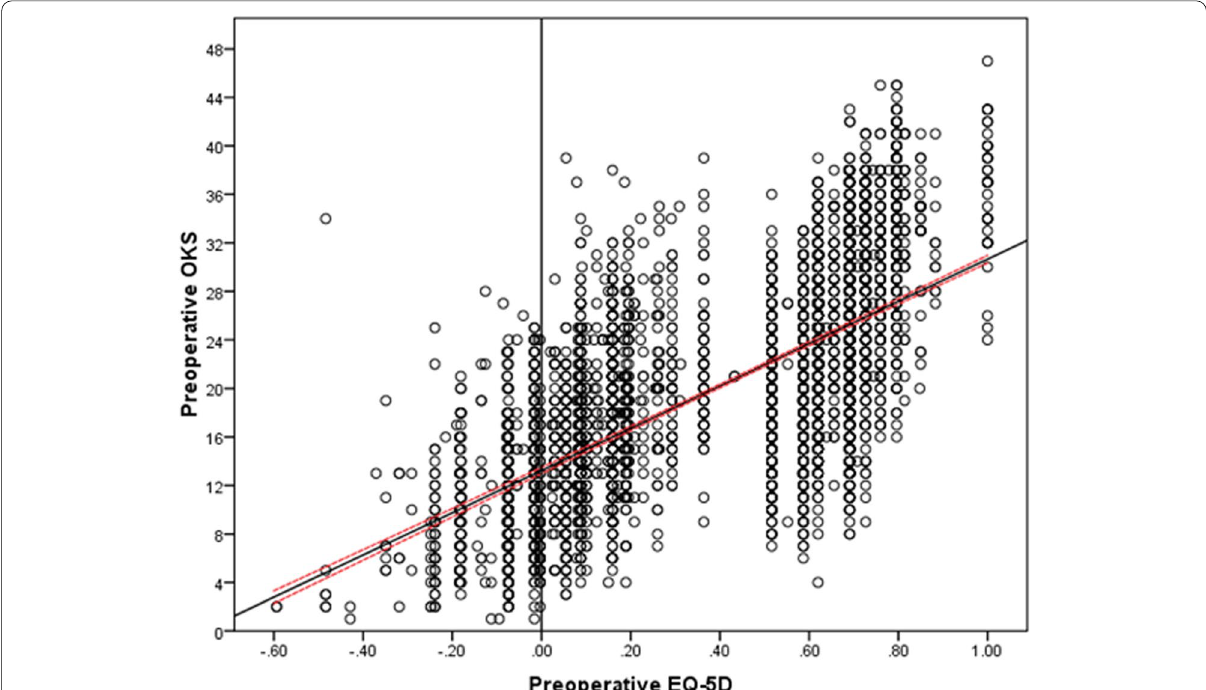
Fig. 1 Scatter plot with linear line of the best fit (black line) and 95% confidence intervals around the mean (red dashed lines) for preoperative EQ-5D and the